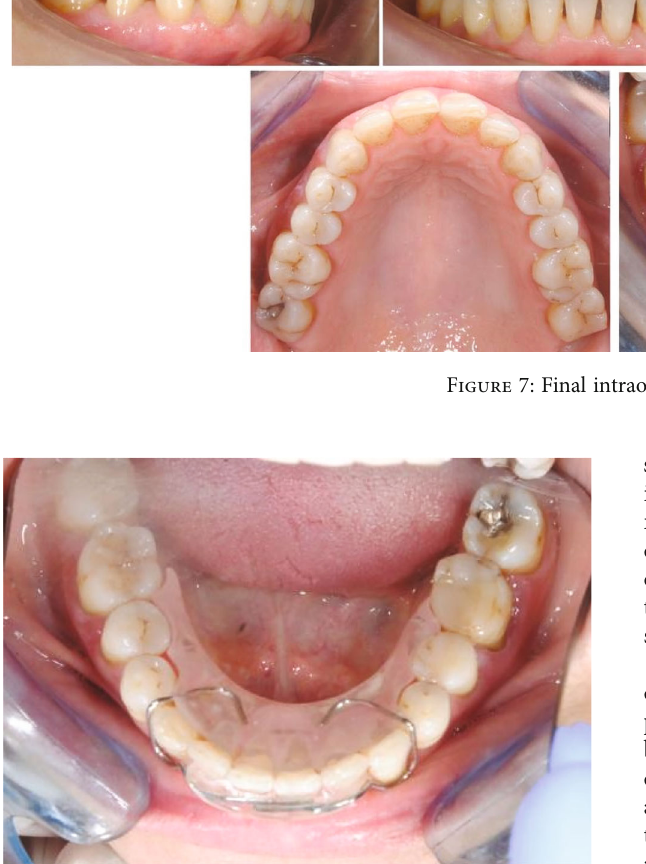
Figure 8: Spring